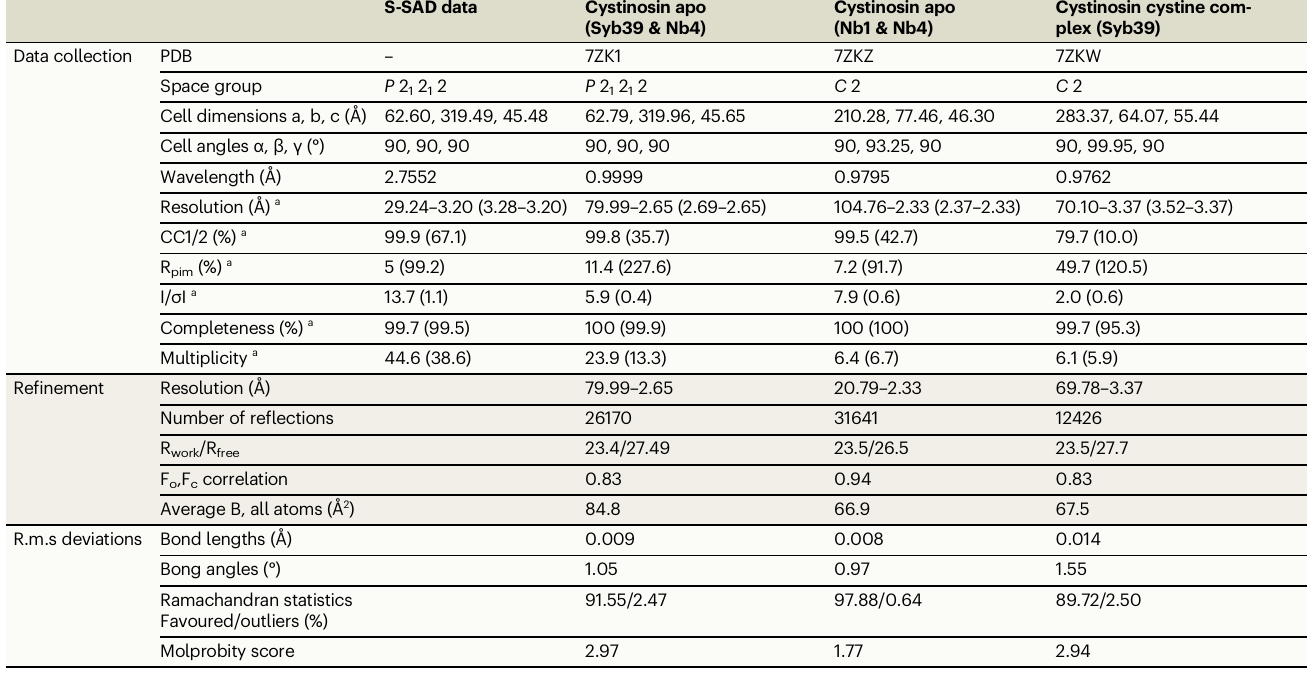
Table 1 | X-ray data collection and re fi nement